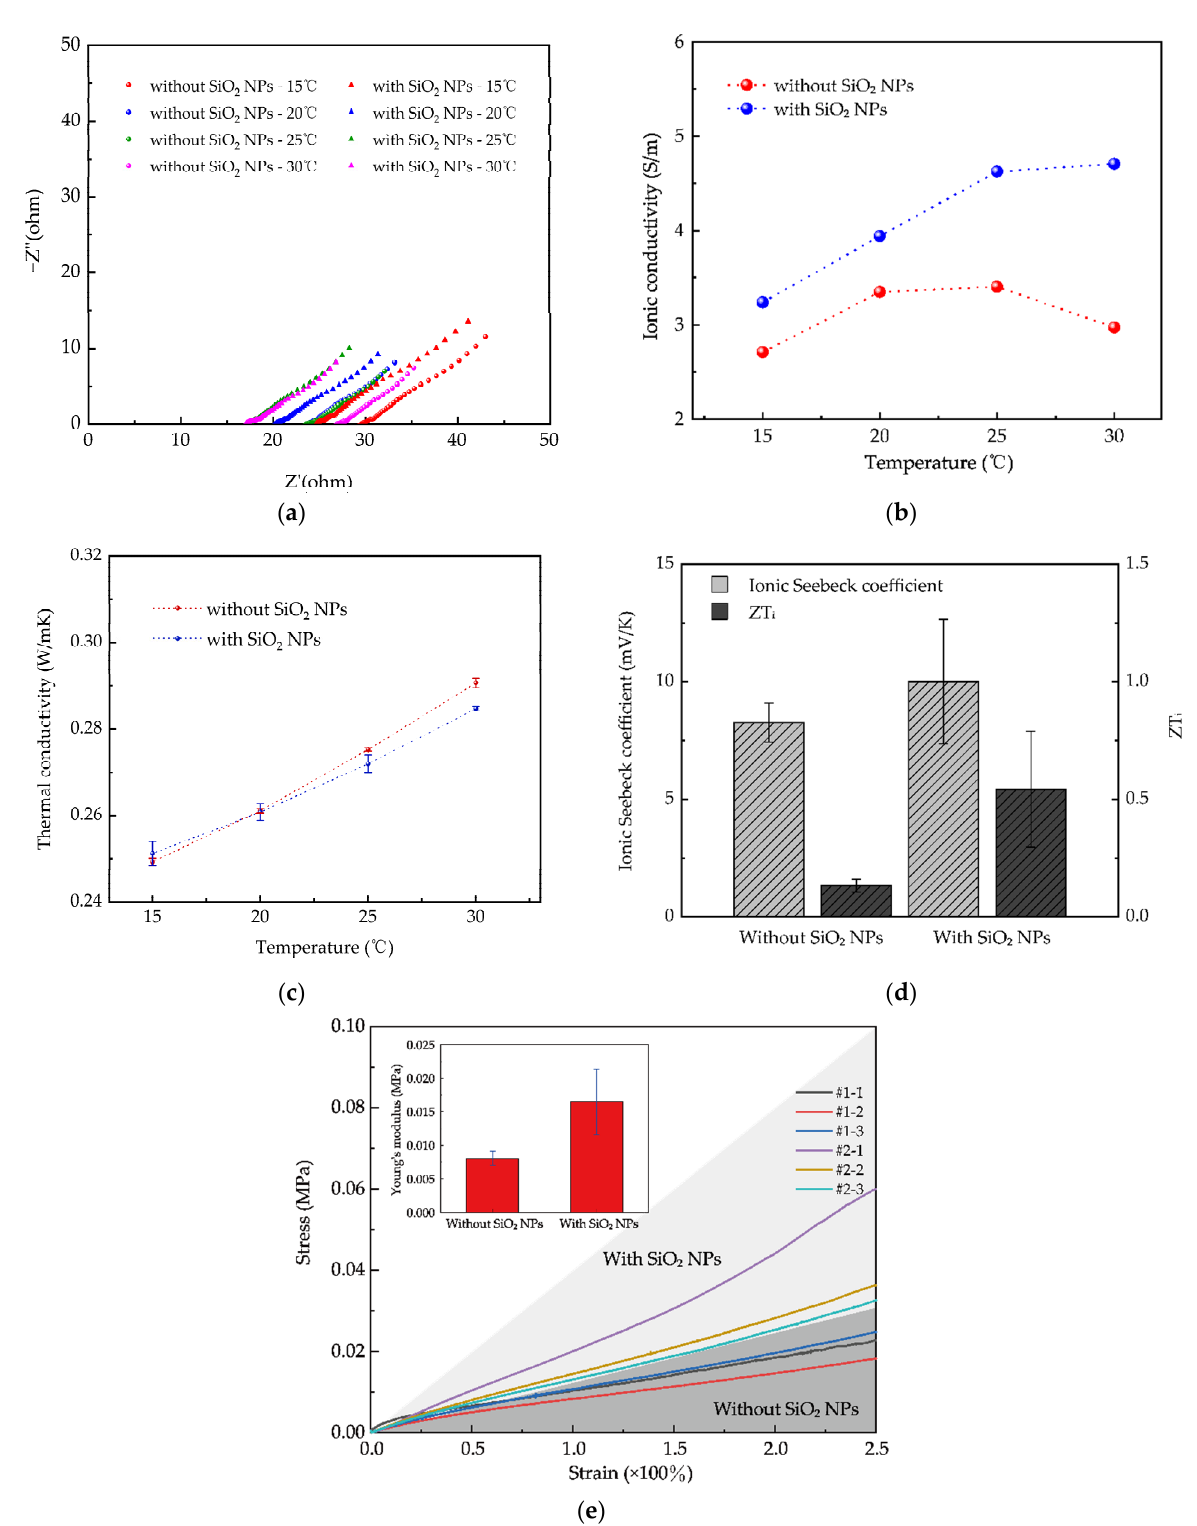
Figure 5. ( a ) Nyquist diagrams of the iTEG at various temperatures; ( b ) the ionic conductivity curves of the iTEG containing SiO 2 NPs and the blank control group; ( c ) the thermal conductivity of the iTEG with or without SiO 2 NPs at various temperatures; ( d ) the S i and ZT i of the iTEG with/without SiO 2 NPs; ( e ) stress–strain curves and Young’s modulus for the iTEG with or without SiO 2 NPs (the experiments are repeated three times in each case).